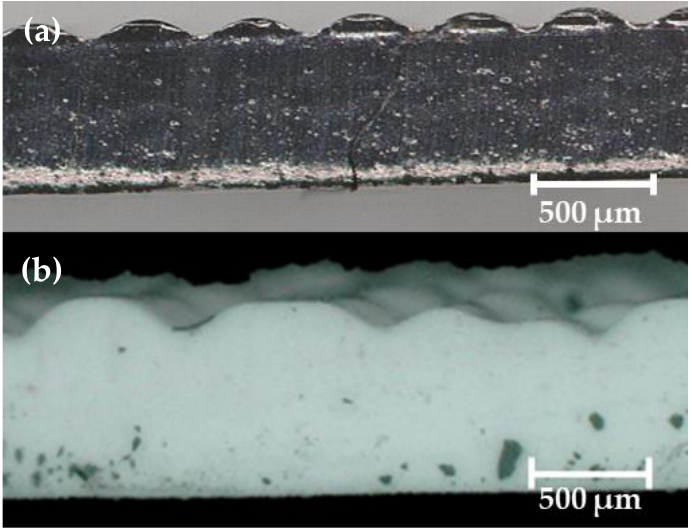
Figure 2. Side view of FCT pads printed with: ( a ) TS-720 and ( b ) 50 wt% Gd 2 O 3 DIW inks.